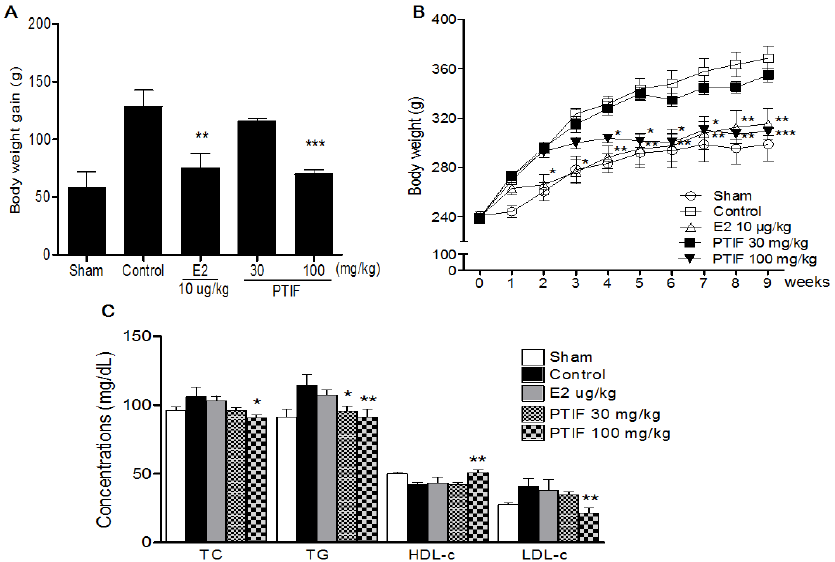
Figure 2. Effects of PTIF on body weight gain ( A ), weekly body weight ( B ) and serum lipid concentrations ( C ) in ovariectomized (OVX) rats. The body weight gain was calculated by the equation: final body weight − initial body weight. All data are the mean ± SEM values ( n = 12 per group). Body weight was statically significant vs . control by repeated-measure ANOVA. Body weight gain and serum concentration were compared with control (one-way ANOVA). * p < 0.05, ** p < 0.01 and *** p < 0.001, significantly different from the OVX-control group.